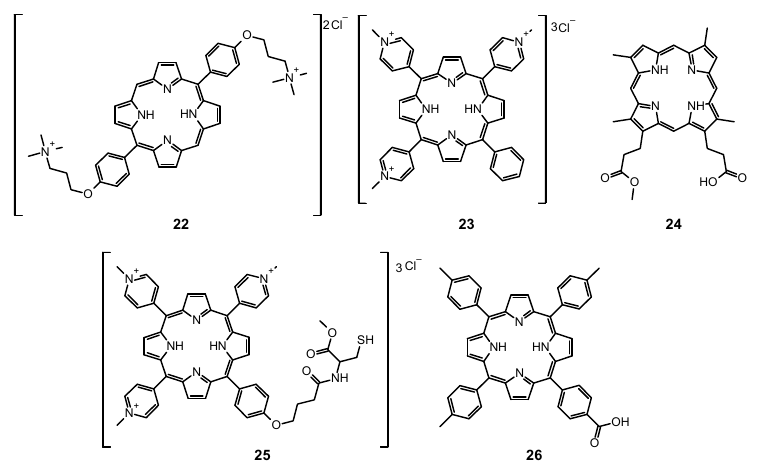
Figure 7. Chemical structures of 22–26. Smijs and Schuitmaker screened a series of PSs for their potential use in photoinac- tivation of T. rubrum [204]. The tested compounds included deuterioporphyrin and its monomethyl ester, 5,10,15-tris ( N -methylpiryd ´ 4-yl) ´ 20-phenylporphyrin trichloride (Sylsens B, 23 , Figure 7), hematoporphyrin, porfimer sodium (from Photofrin ® ), zinc (II) phthalocyanine, phthalocyanine tetrasulfonic acid, and chloroaluminium (III) phthalocya- nine tetrasulfonic acid. It was found that porfimer sodium and phthalocyanines were less active in PACT experiments, exhibiting a fungistatic effect, while the tested porphyrins induced photokilling of the fungus. Among them 23 and hematoporphyrin monomethyl ester were the most effective PSs but Sylsens B exhibited no dark toxicity [204]. The topic was continued, as Smijs et al. reported assessment of the PACT of those two porphyrins on T. rubrum grown on human stratum corneum ex vivo model [205]. The authors noticed that the efficacy of PACT was strongly dependent on the time after the inoculation of the fungus, as well as the medium used for application of the PS [205]. Further research was focused on the optimal conditions for PACT using 23 and deuterioporphyrin monomethyl ester ( 24 , Figure 7) [206]. These studies revealed that 23 was a better PS when such opti- mal conditions of pH~5 and low ionic strength of the medium were applied [206]. This acquired information was used in a following study aimed to determine the usefulness of 23 towards photoinactivation of reference T. rubrum and its clinical isolate [207]. Different modes of application and dosimetry were tested for efficient photokilling of the fungi. The authors also highlighted the possibility of penetration of 23 to the skin when it was applied at pH 7.4 but not at pH 5.2. However, use of a surfactant made it possible for the PS to cross the stratum corneum barrier [207]. Further studies were performed to test the efficacy of PACT of 23 and its analogues—5,10,15-tris ( N -methylpyrid ´ 4-yl) ´ 20- (4-sulfanylphenyl)porphyrin trichloride and 5,10,15-tris( N -methylpyrid ´ 4-yl) ´ 20-{4-[(1- methoxy ´ 1-oxo ´ 3-sulfanylpropan ´ 2-yl)amino] ´ 4-oxobutoxyphenyl}porphyrin trichlo- ride ( 25 , Figure 7) [208]. The PSs were assessed in in vitro photoinactivation of a clinical isolate of T. mentagrophytes , as well as ex vivo permeation into the nail. T . mentagrophytes viability was decreased upon irradiation with the PSs, 4.6, 4.4 and 3.2 log reduction was recorded for 5,10,15-tris ( N -methylpyrid ´ 4-yl) ´ 20- (4-sulfanylphenyl)porphyrin trichlo- ride, 23 and 25 , respectively, when the same conditions were applied. However, the latter was more photostable and more active when low oxygen concentration conditions were as- sessed [208]. This research was continued by Hollander et al., who tested the effectiveness of using 25 as a PS in PACT against ex vivo onychomycosis caused by either T. rubrum , T. mentagrophytes , or Trichophyton tonsurans [209]. Each of the microorganisms was affected by the photodynamic treatment, as the viabilities decreased in every case at least by 70% after single irradiation. After the second irradiation all the onychomycoses were cured. The authors report that the effec-